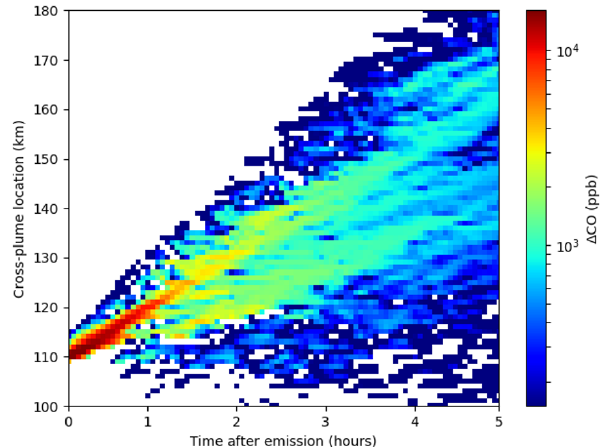
Figure 2. SAM-ASP Williams fire simulation of cross-plume loca- tion versus time since emission at a vertical height of 1200m for (cid:49) CO. Note that figure is zoomed in on the plume with white back- ground indicating a concentration of less than